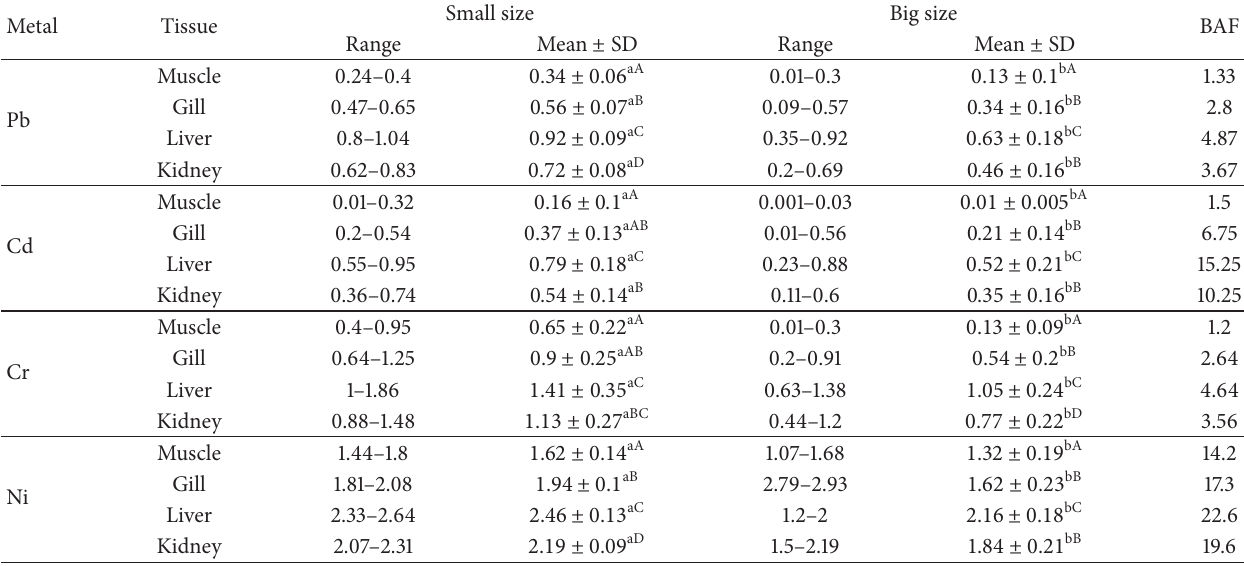
Table 3: Heavy metal concentrations in different organs ( 𝜇 g/g wet wt.) of P. argenteus and bioaccumulation factor